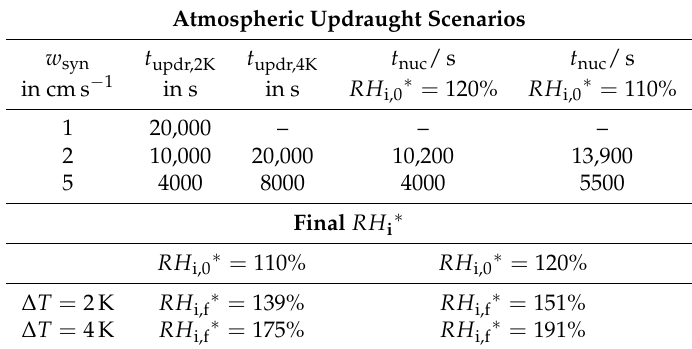
Table 2. Characteristics of the various updraught scenarios: updraught speed w syn , updraught duration t updr,2K and t updr,4K for a 2K or 4K cooling, respectively and the approximate time of cirrus formation t nuc for RH i,0 ∗ = 120% and RH i,0 ∗ = 110%, respectively. The second block lists the final RH i values RH i,f ∗ as a function of ∆ T and RH i,0 ∗